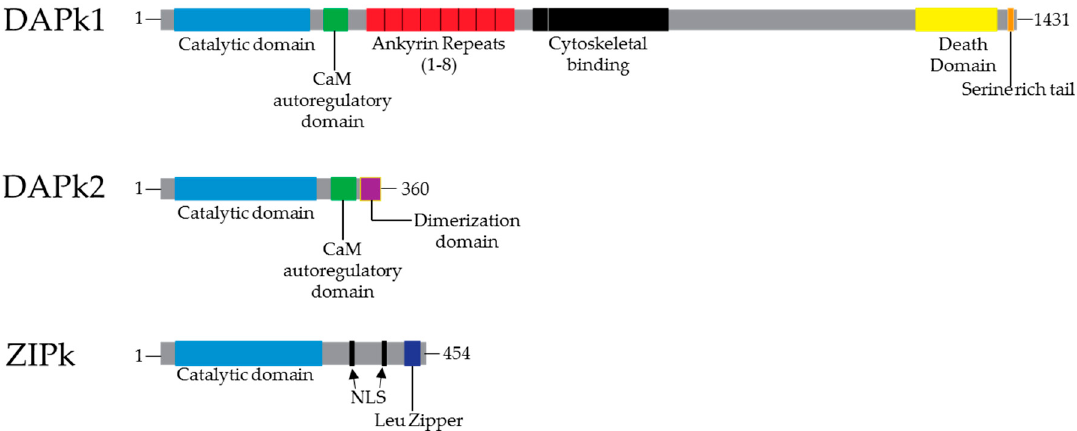
Figure 1. Schematic representation of the multi-domain organization of death associated protein kinase DAPk1 (death-associated protein kinases 1), and ZIPk. The catalytic domain, a death domain, and ankyrin repeats, which may mediate its interaction with other proteins. The cytoskeleton-binding region is responsible for DAPk1 intracellular localization to actin microfilaments. DAPk1 and DAPk2 are activated by a rise in cytosolic calcium concentrations resulting from cellular stresses, through binding of calcium-activated calmodulin [33]. NLS = nuclear localization signal.